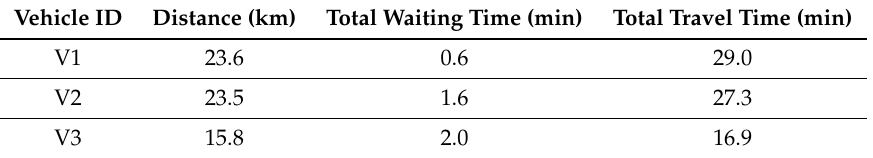
Table 3. Calculated results of scenario